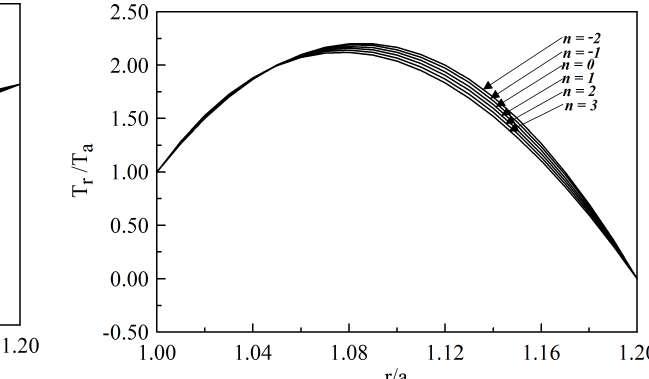
Figure 33: Radially distributed radial stress